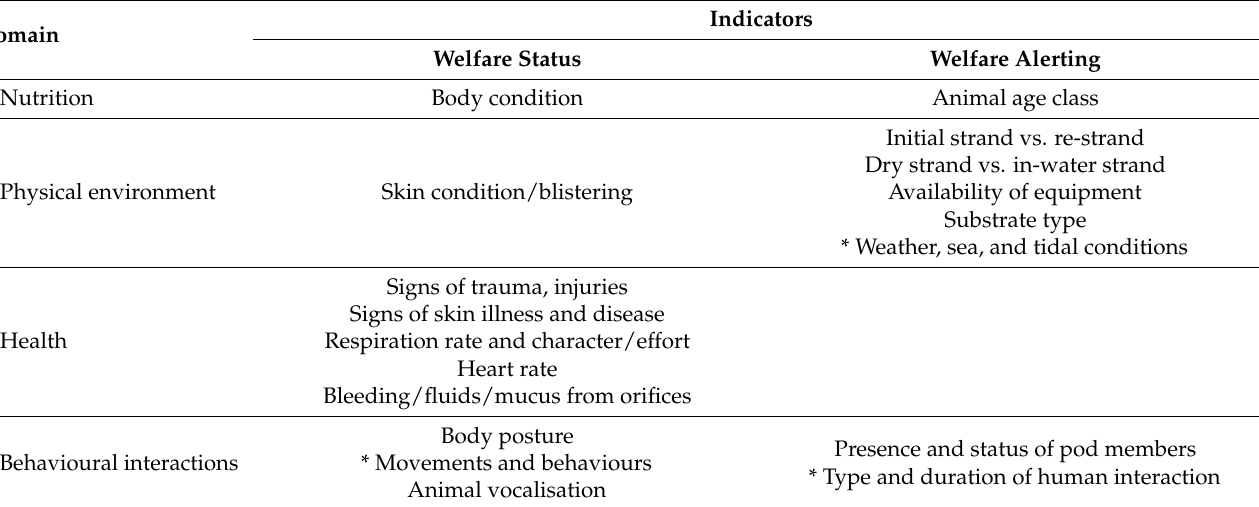
Table 1. Proposed animal welfare indicators, or composite indicators *, organised into the three physical/functional domains and one situation-related domain of the Five Domains Model for welfare assessment [35]. Within each domain, indicators are organised according to the type of information they provide about the animal’s state. See text for details of each indicator and how it was measured or